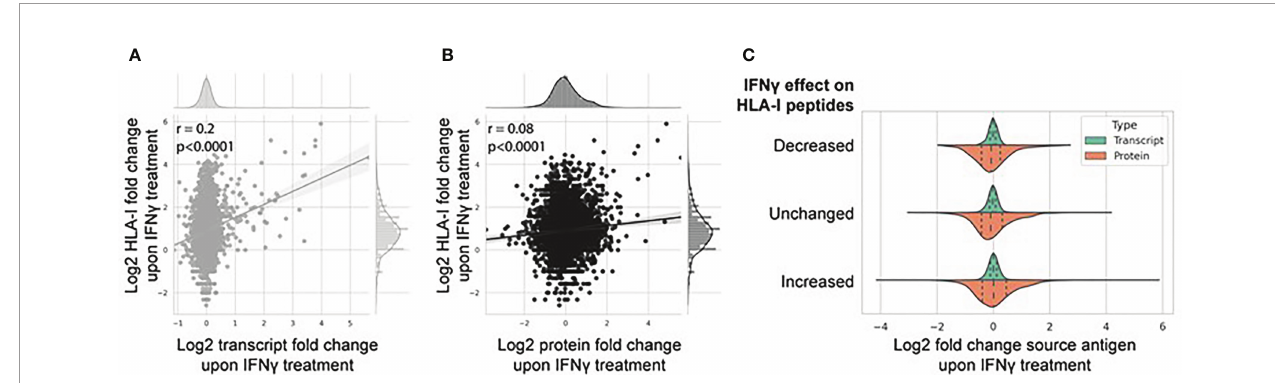
FIGURE 5 | IFN g -mediated modulation of the immunopeptidome is only weakly re fl ected by changes in the transcriptome and proteome. Correlation regression plot between the log 2 fold change of the number of HLA-I peptides per protein with the associated log 2 fold change of source transcript (A) and source protein (B) following IFN g treatment. (C) Distribution of source transcript and protein log 2 fold change, binned into categories of HLA-I peptide per protein presentation following IFN g treatment [decreased (<0.5-fold); unchanged (0.5-fold to 1.5-fold); increased